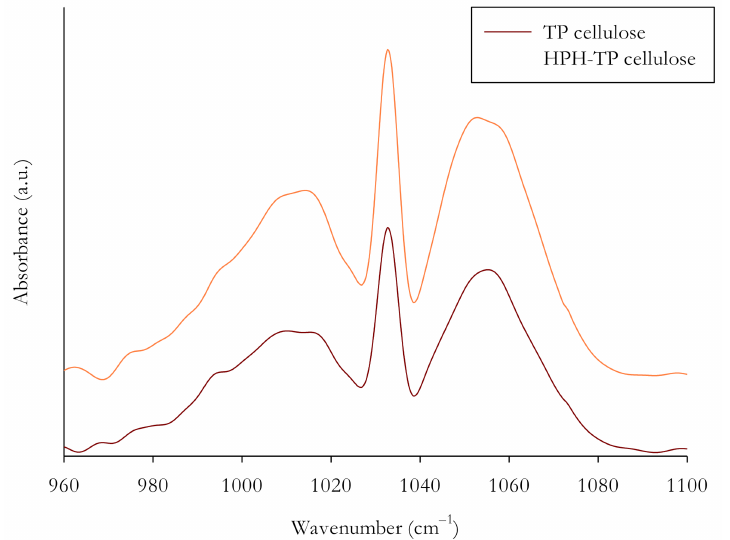
Figure 5. FT-IR absorbance spectra of the solid residues from TP (dark-red line) and HPH-TP samples (orange line), obtained after the cascade chemical treatments.